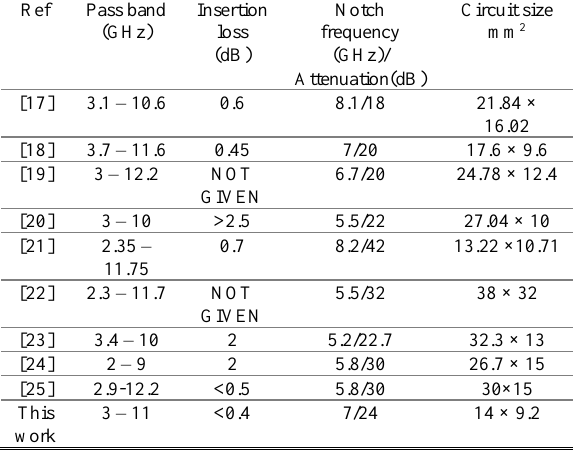
TABLE 2. The presented UWB BPF and recently reported filters comparison